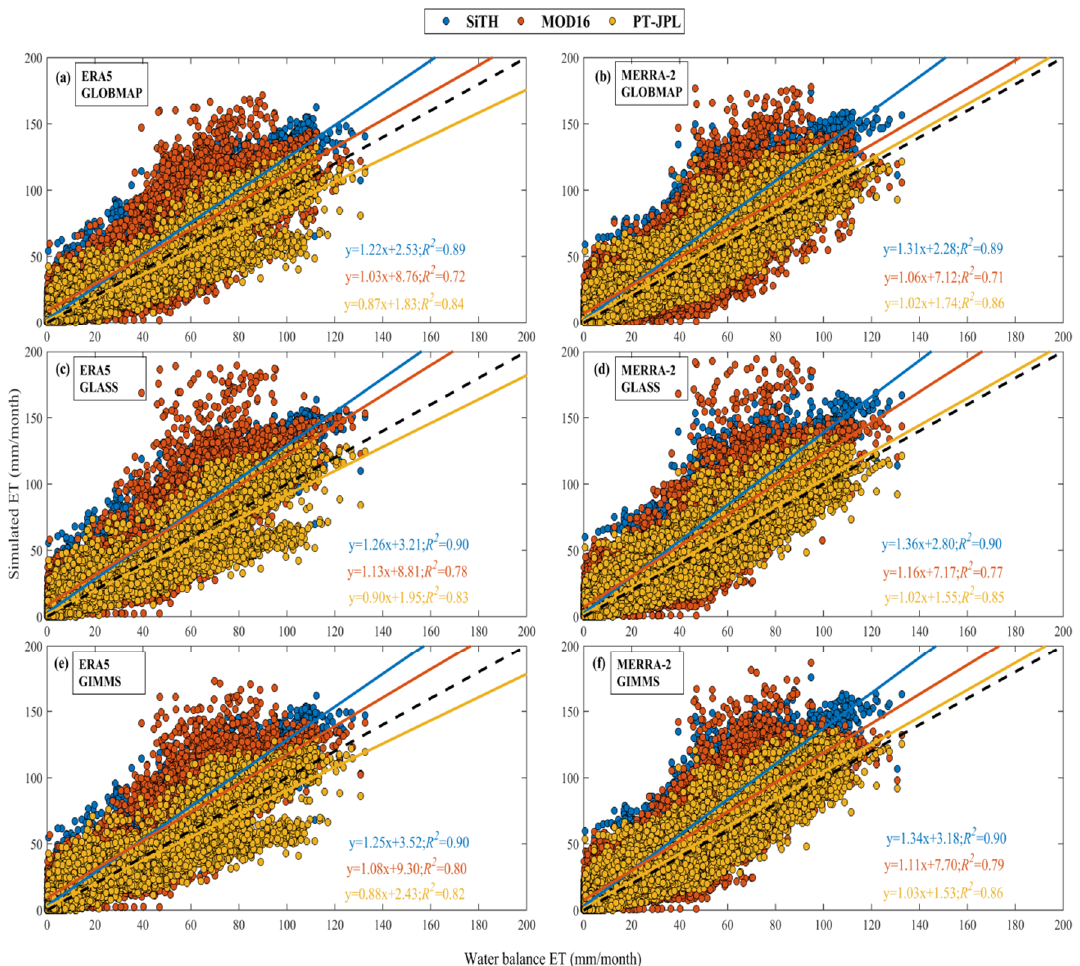
Figure 4. Scatter plots of the simulated ET by three models using different forcing datasets versus measured ET at 32 catchments. On the left panels, the same meteorological datasets of ERA5 and different LAI datasets of ( a ) GLOBMAP, ( c ) GLASS, and ( e ) GIMMS was used to estimate ET, respectively. On the right panels, the same meteorological datasets of MERRA-2 and different LAI datasets of ( b ) GLOBMAP, ( d ) GLASS, and ( f ) GIMMS was used to estimate ET, respectively. The black dotted line represents the 1:1 line.